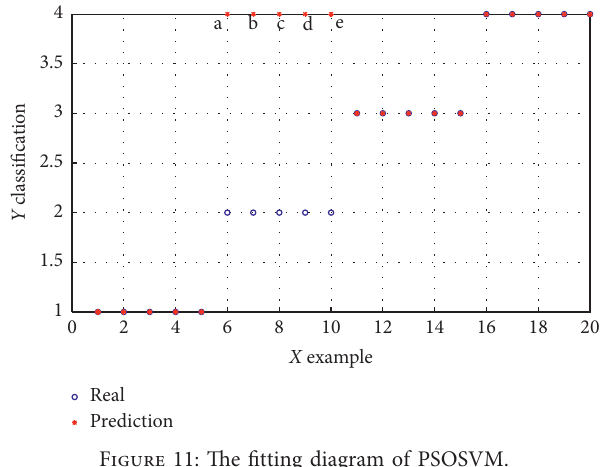
Figure 11: The fitting diagram of PSOSVM.